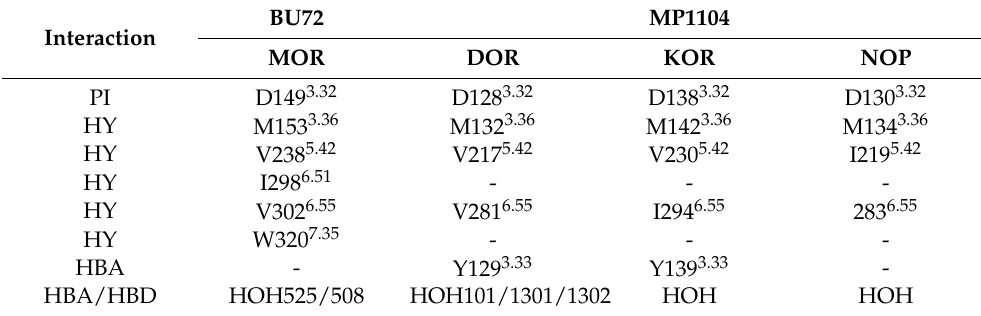
Table 3. Ligand–receptor interactions used for rescoring of docking